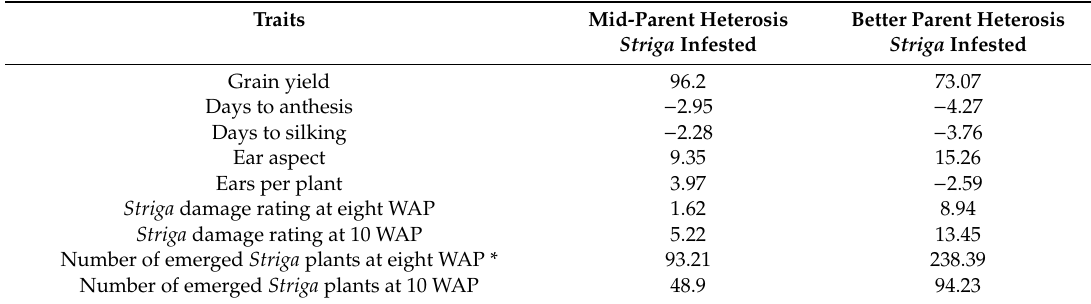
Striga -infested